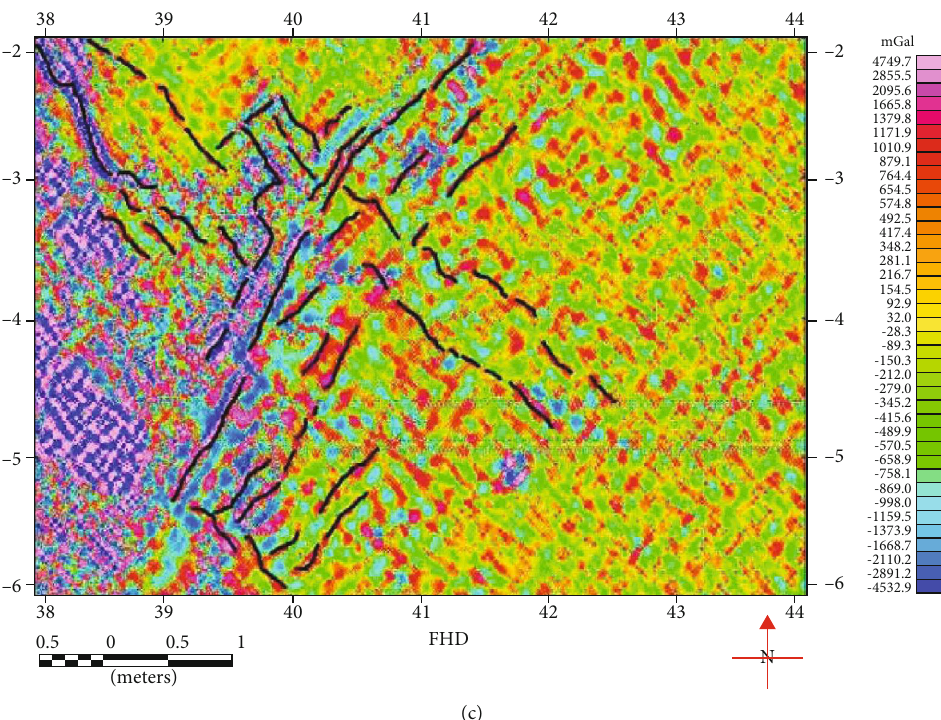
Figure 5: (a) Shows the fi rst horizontal derivative. (b) Shows the Gaussian high pass fi lter at the shallow depth of 1756m. (c) First horizontal derivative with highlighted